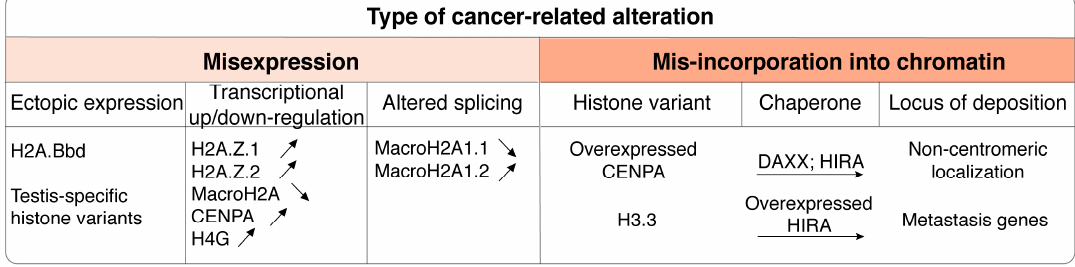
Figure 6. Alterations of histone variants in cancer. Cancer-associated histone variant alterations include, in addition to point mutations (see Figure 4), different types of misexpression (up and down arrows indicate overexpression and downregulation, respectively) and incorporation in chromatin at ectopic loci, mediated by specific histone chaperones.